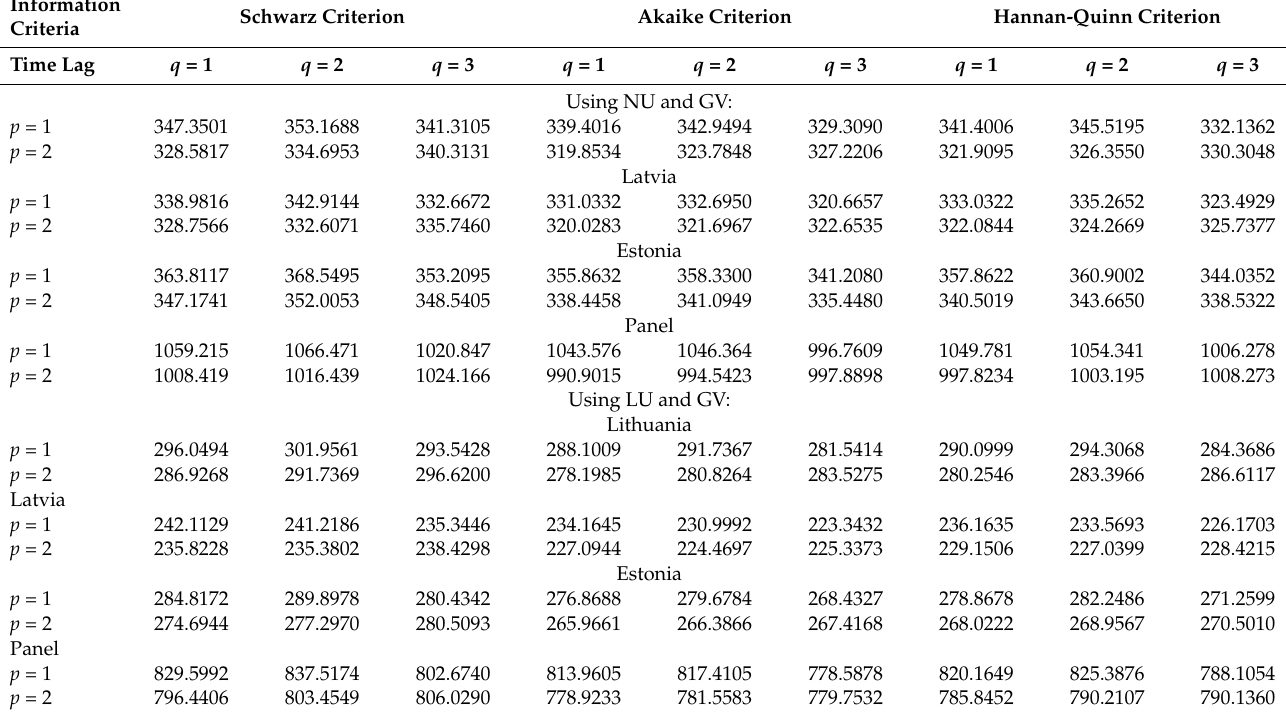
Table A1. Information criteria for best time lag